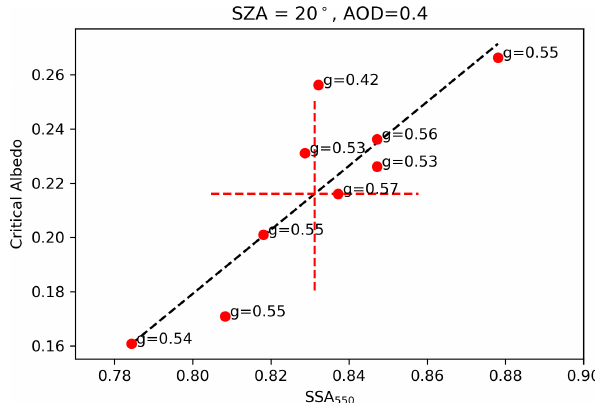
Figure 7. Critical albedo as a function of mid-visible SSA. The red dashed cross shows the case-average α crit